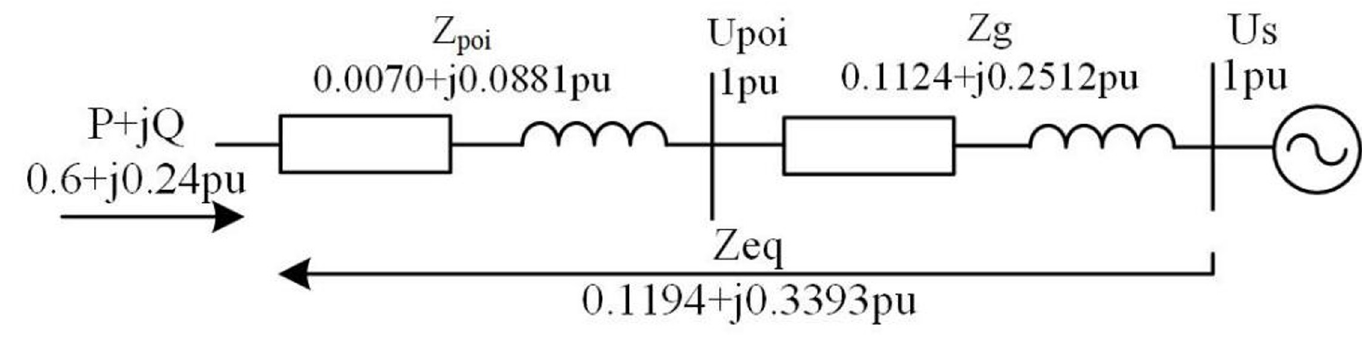
Fig 1. Equivalent circuit